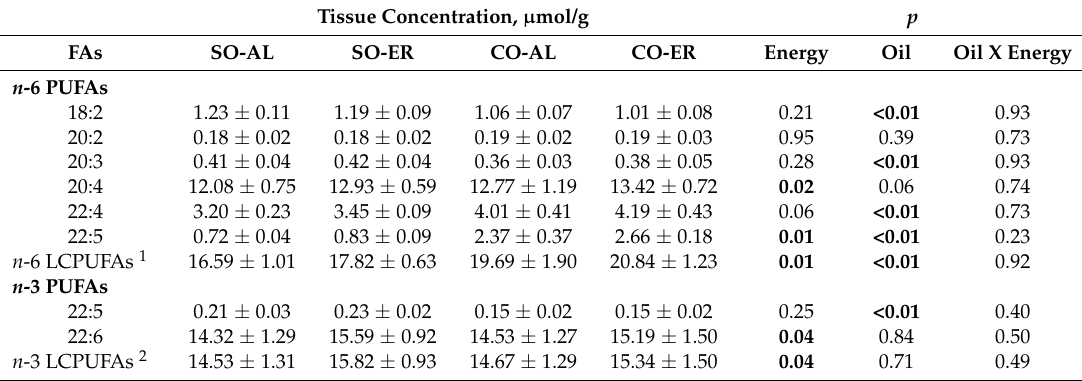
Table 5. PUFA concentration in the cerebral cortex of juvenile male